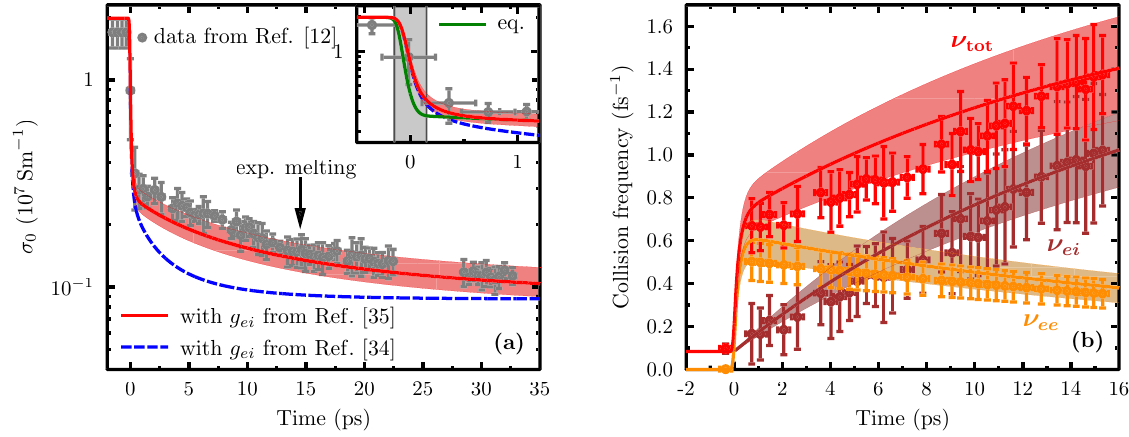
Figure 2. Transient DC conductivity and scattering frequencies in XUV excited gold. Results of our model (lines) are compared to experimental data (symbols with errorbars) taken from Ref. 12 where the shaded areas reflect the uncertainty of the absorbed energy in the experiment. The modelling uses time-dependent band occupations and temperatures from the three-band rate equations (1) as shown in Fig. 1. ( a ) DC conductivity with electron–phonon coupling applied according to Ref. 35 (red solid line) and Ref. 34 (blue dashed line). Note the logarithmic scale of the conductivity σ 0 ( t ) when assessing the deviations. The arrow indicates the time of melting as observed in the experiment. The inset compares our full modelling with data assuming instant equilibration between the bands (green line). ( b ) Total electron scattering rate (red) and its contributions from electron–phonon scattering (brown) and electron–electron scattering